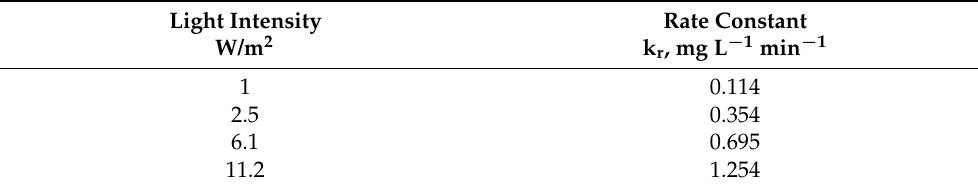
Table 5. Langmuir-Hinshelwood constant ( k r ) values at various light intensities.